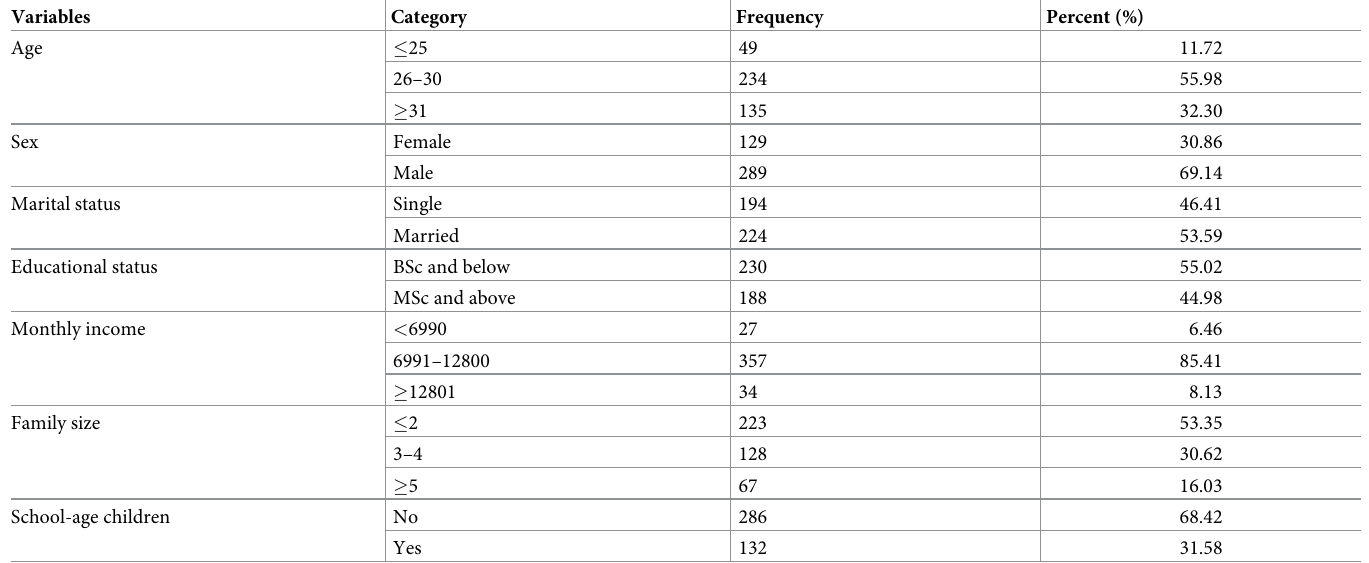
Table 1. Socio-demographic characteristics of study participants (N =